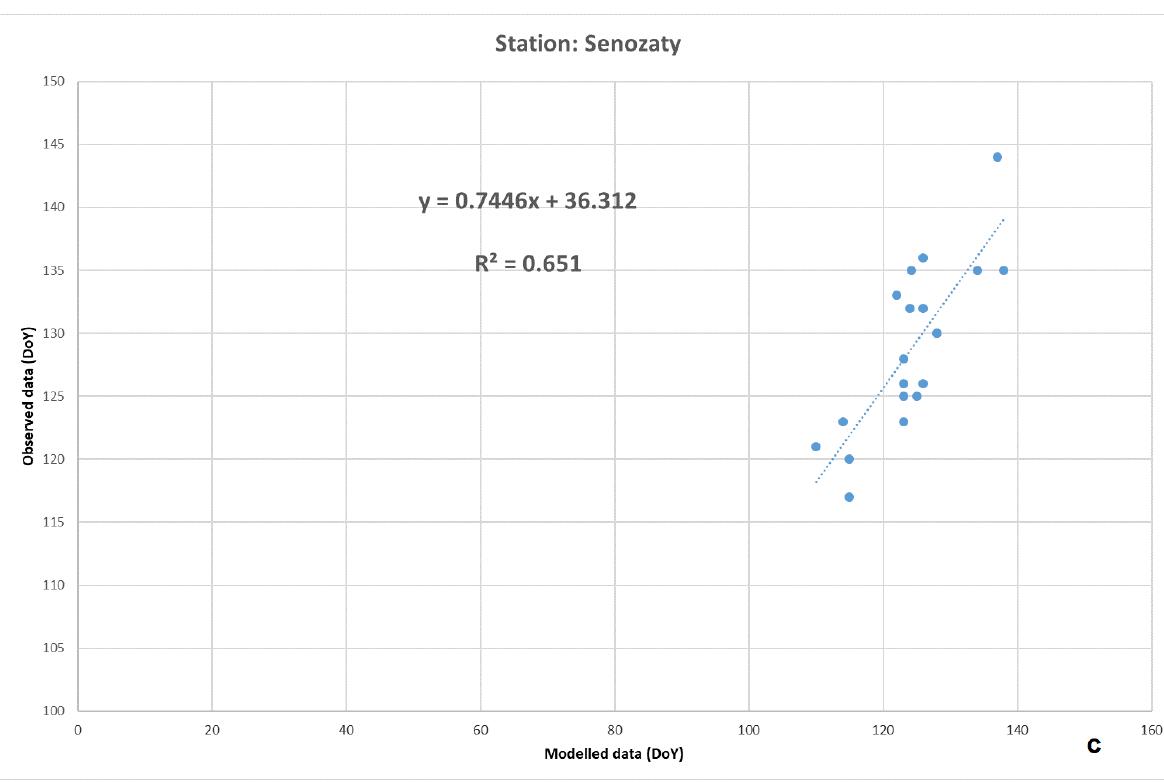
Figure 5. Scatter plots of real observed data and modeled data of the beginning of flowering of the Brassica napus based on the PhenoClim model (STT). Stations are listed by altitude—Kujavy ( a ), Chrastava ( b ) and Senozaty ( c ).